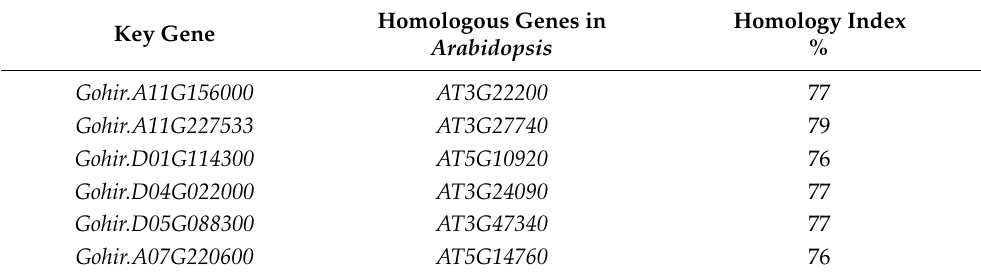
Table 9. Key regulatory genes in the alanine, aspartate, and glutamate metabolism pathway. Key